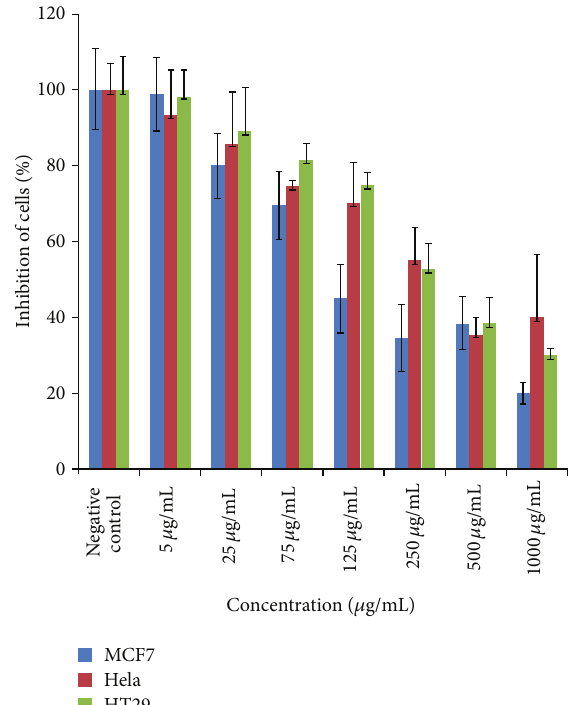
Figure 1: Effect of S. birrea acetone extract on proliferation of MCF- 7, HT-29 and HeLa cells at 24h. Each value represented mean ± SEM of six replicates ( 𝑛 = 6